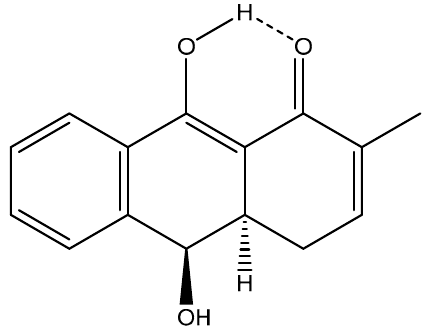
Figure 16. Structure of Rubia philippinensis as suggested in [78].